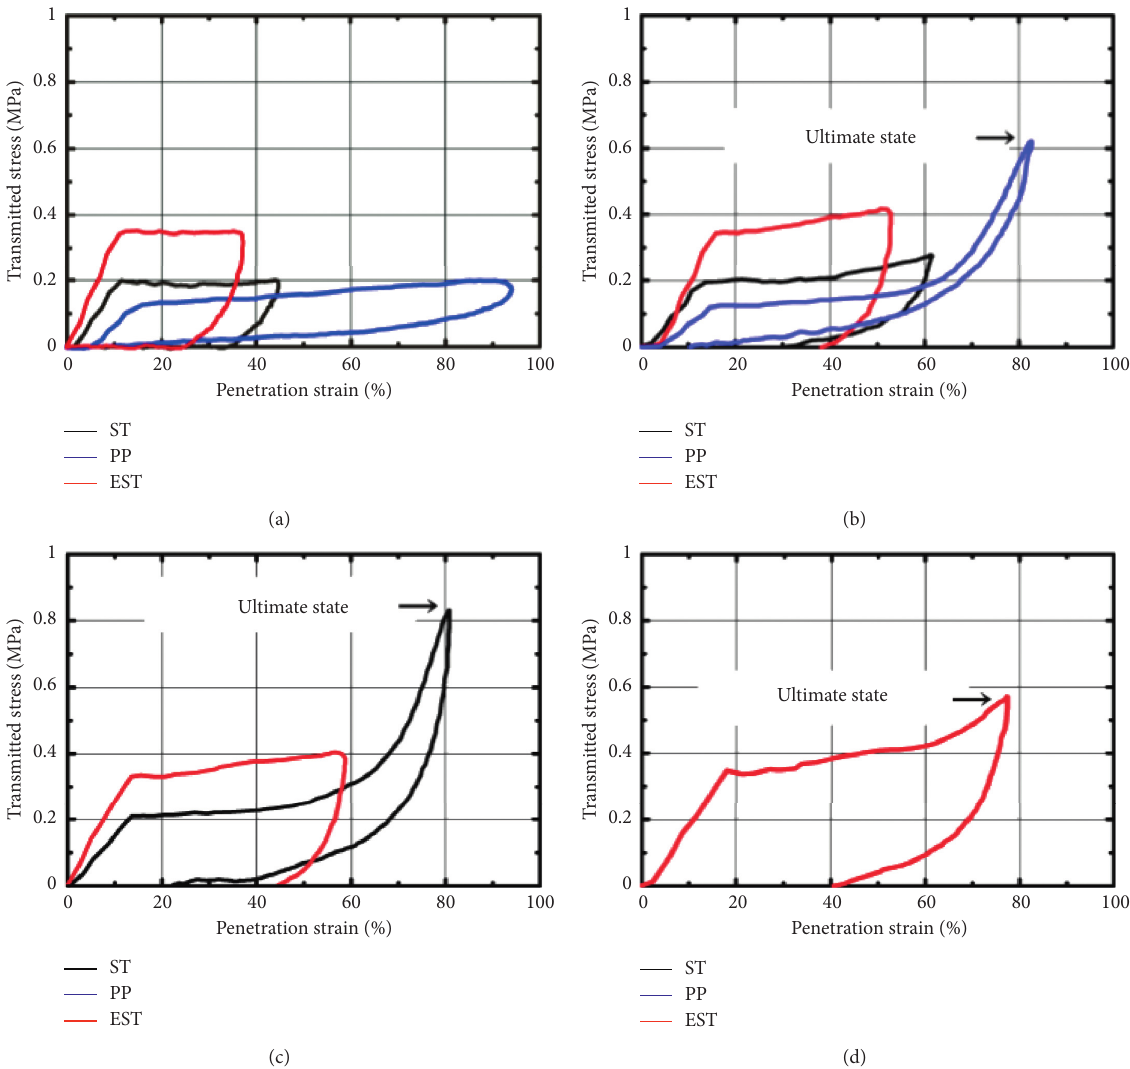
Figure 12: Transmission impact stress-penetrating distortion hysteresis loop in the case with a core slab. (a) H � 200mm. (b) H � 300mm.